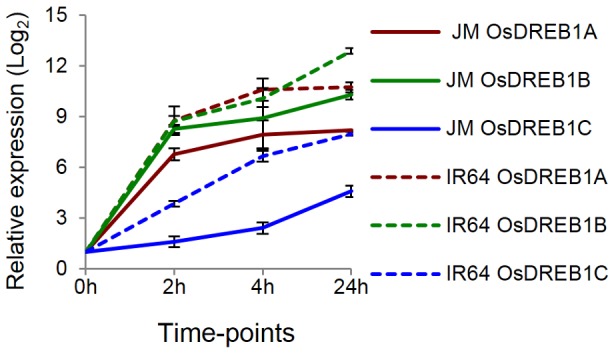
Monitoring OsDREB1 mRNA levels in JM and IR64 by quantitative real-time RT-PCR.Relative expression levels of OsDREB1a, OSDREB1b and OsDREB1c at 0 h, 2 h, 4 h and 24 h measured by quantitative real-time RT-PCR measured in biological triplicates. Solid line represents JM and dashed line represents IR64.